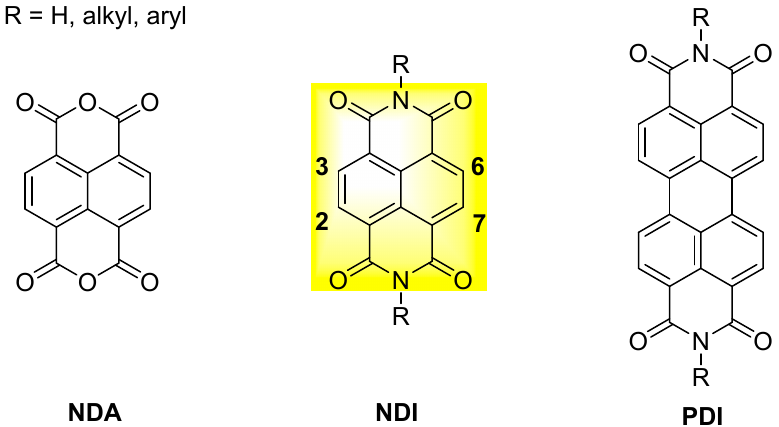
Figure 3. General structure of naphthalene dianhydride (NDA), naphthalene diimide (NDI) and perylene diimide (PDI).